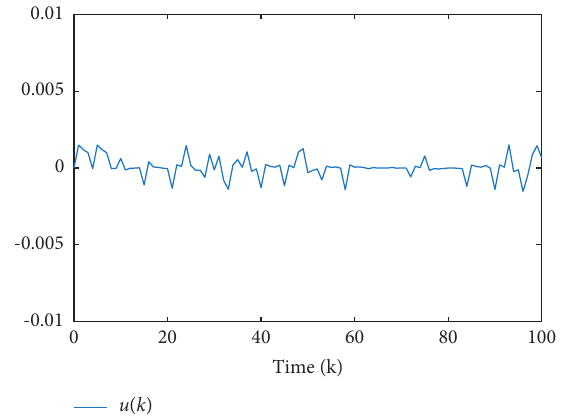
Figure 3: The trajectory of controller input u ( k ) .